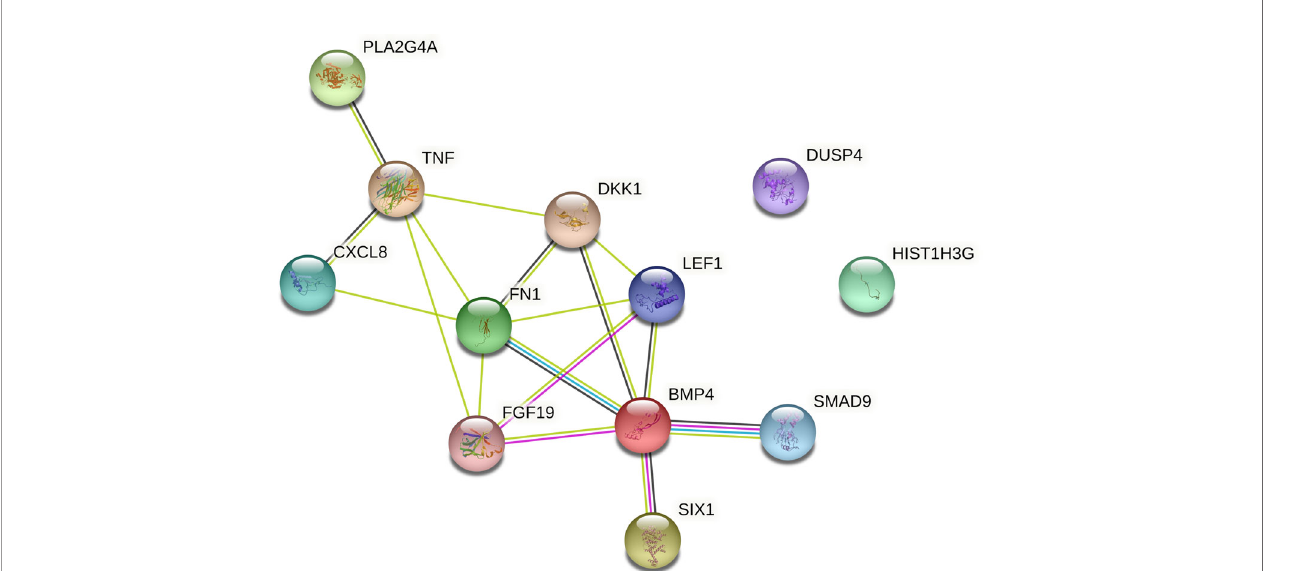
FIGURE 2 | STRING interaction network of the 12 genes differentially expressed in the recurrence and nonrecurrence groups of patients [known interactions (light blue – from curated databases; purple – experimentally determined); predicted interactions (green, gene neighborhood; red, gene fusions; dark blue, gene cooccurrence); others (yellow, text mining; black, coexpression; gray, protein homology)].